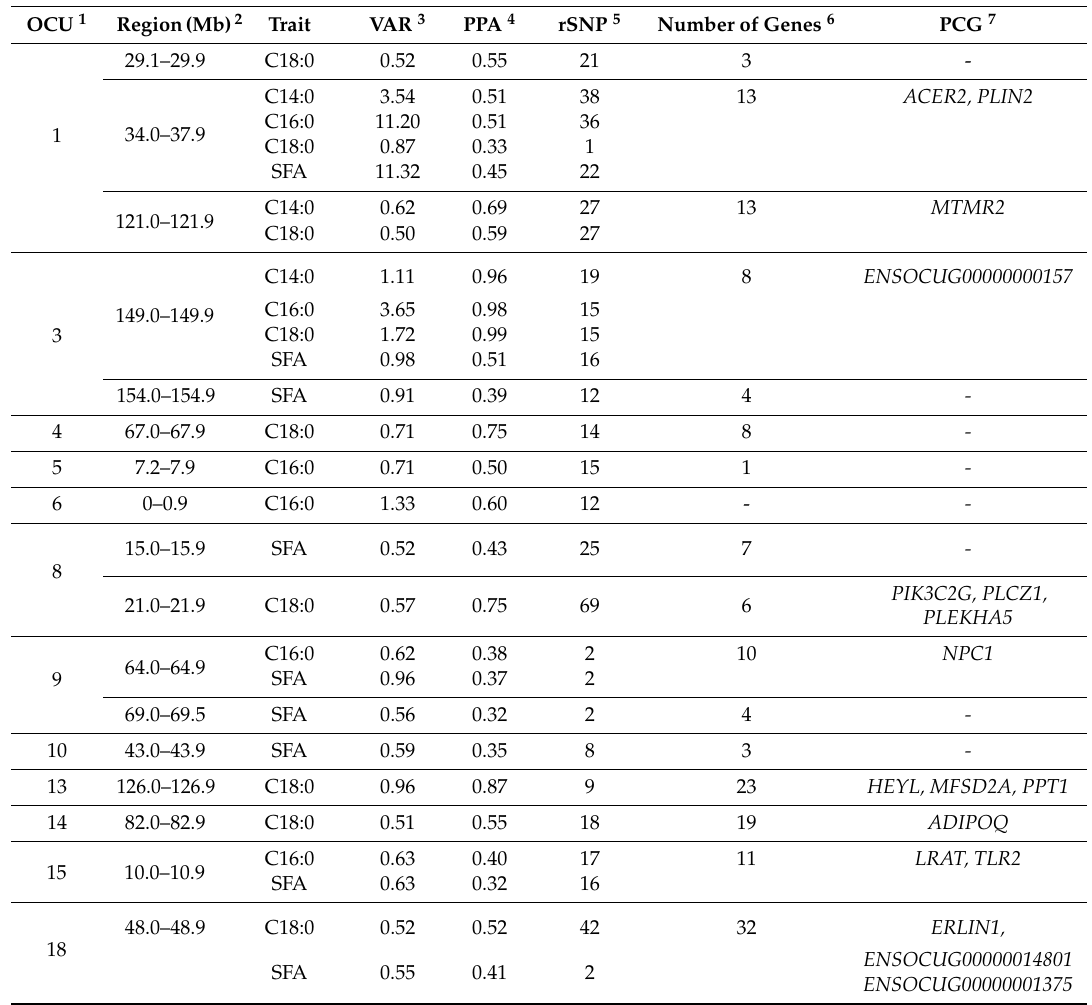
Table 2. Genomic regions associated with saturated fatty acids of Longissimus thoracis et lumborum muscle in